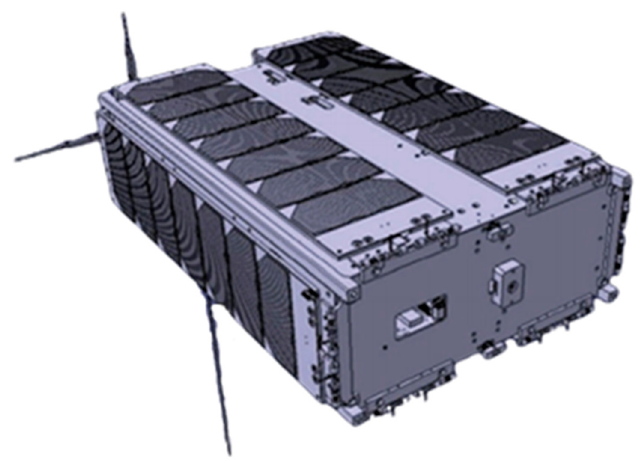
Figure 1. Structural Design of